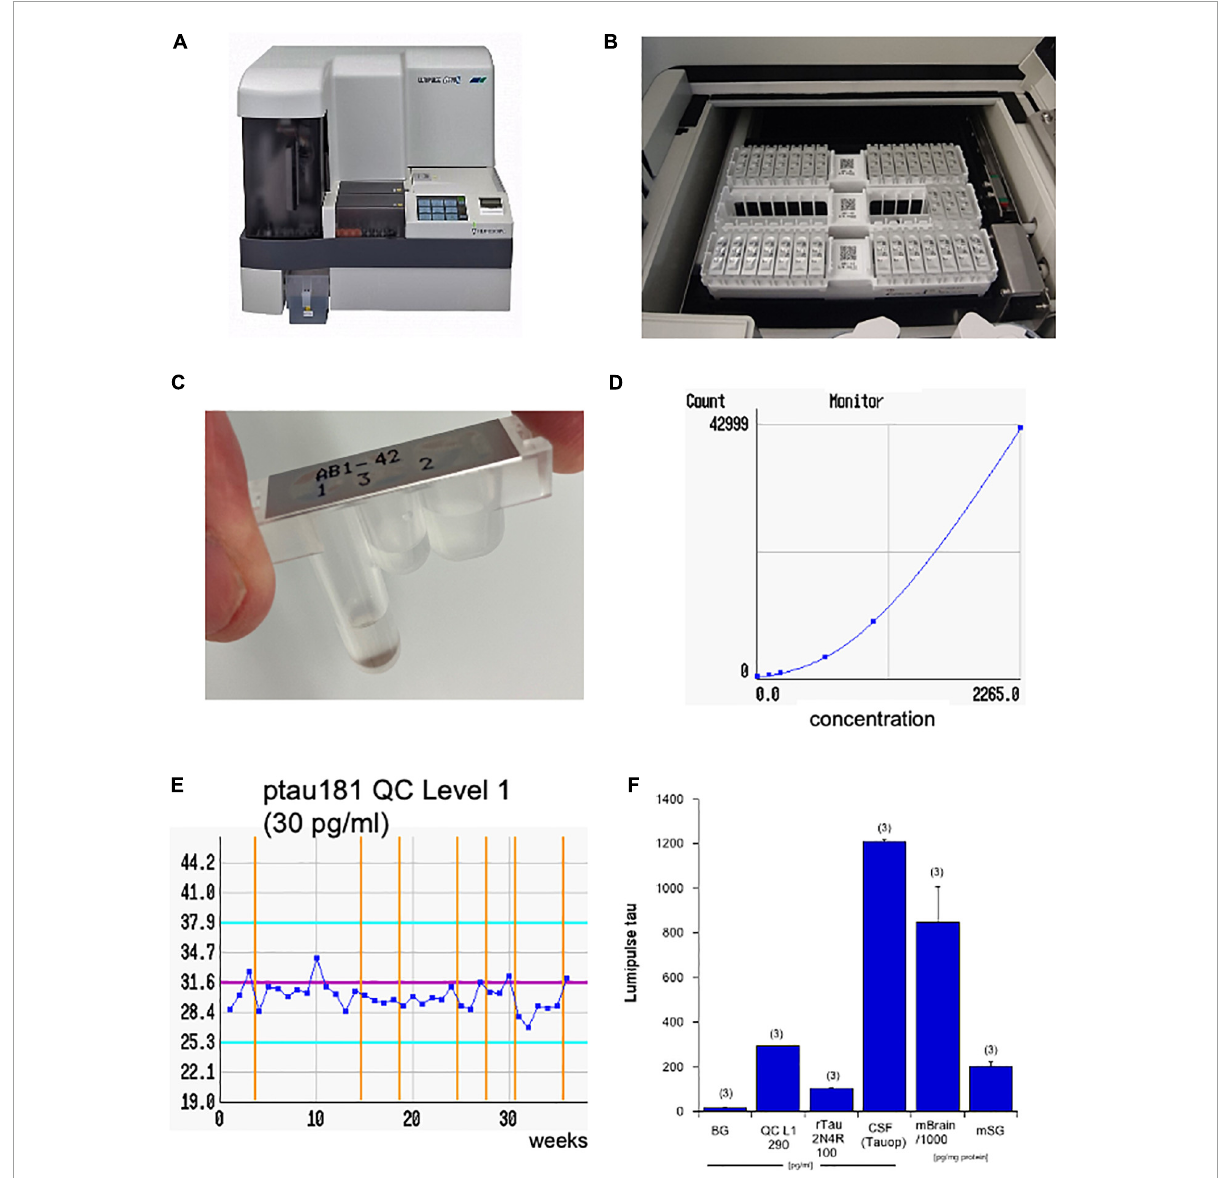
FIGURE1 The four AD biomarkers were analyzed using the Lumipulse G600II (A) . The principle is an enzymatic reaction, where the antibodies and magnetic beads are stored in three different tubes within a single unit located on a rack with 14 units (B,C) . The computer generates a standard curve (D ; e.g., for tau) and quality controls (QCs; e.g., for phospho-tau-181, 30 pg/ml) to guarantee an accurate analysis over weeks (E) . Values are generated from standards and display a very low background (BG) versus the tau quality level 1 (290 pg/ml), a recombinant 2N4R tau standard (100 pg/ml), as well as a cerebrospinal fluid (CSF) sample of a patient with tauopathy (Tauop) (F) . As a control tau levels are also shown in a mouse brain (mBrain) or in a mouse male salivary gland (mSG). The later ones are corrected for total protein and are given as pg/mg.